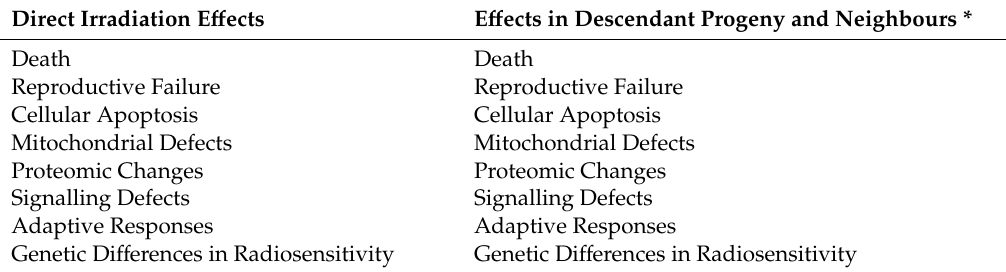
Table 1. Reported Effects. Table 1. Reported E ff ects.